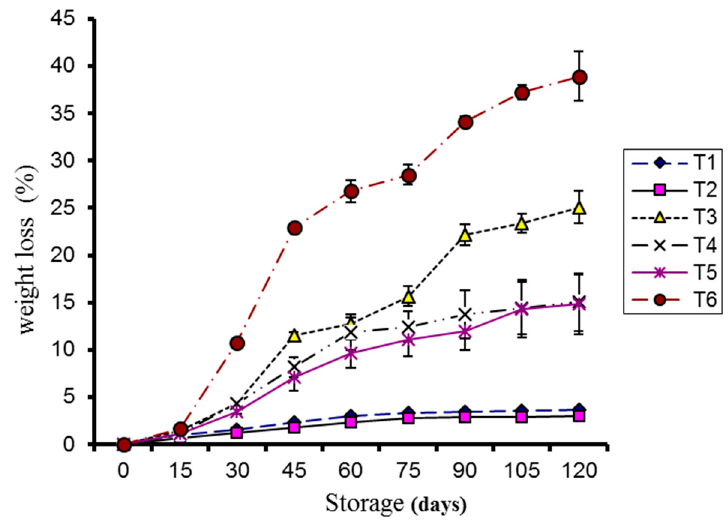
Figure 1. Effect of CMC and guargum-based silver nanoparticle coatings on the weight loss of kinnow fruit stored at 4 and 10 °C. The vertical bars represent standard error of the means. Values represented as mean ± SE of three replicates.